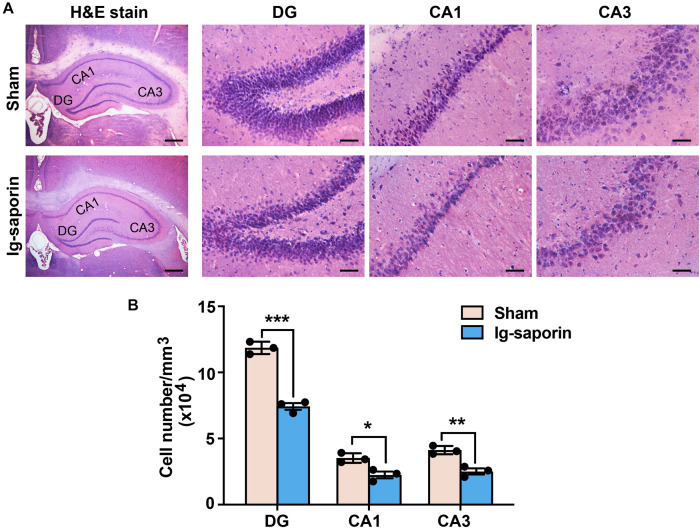
Effects of 192 IgG-saporin on the morphological alterations and toxicity in the dentate gyrus (DG) and CA3 and CA1 regions of the hippocampus. (A) H&E staining showed a reduce of the number of cells in the hippocampus. (B) Quantitative analysis revealed significant differences in the total number of pyramidal neurons between the two groups (n = 3 per group). Data are represented as mean ± SEM; *p < 0.05, **p < 0.01 and ***p < 0.001. Scale bars: 500 μm; 50 μm (inset).